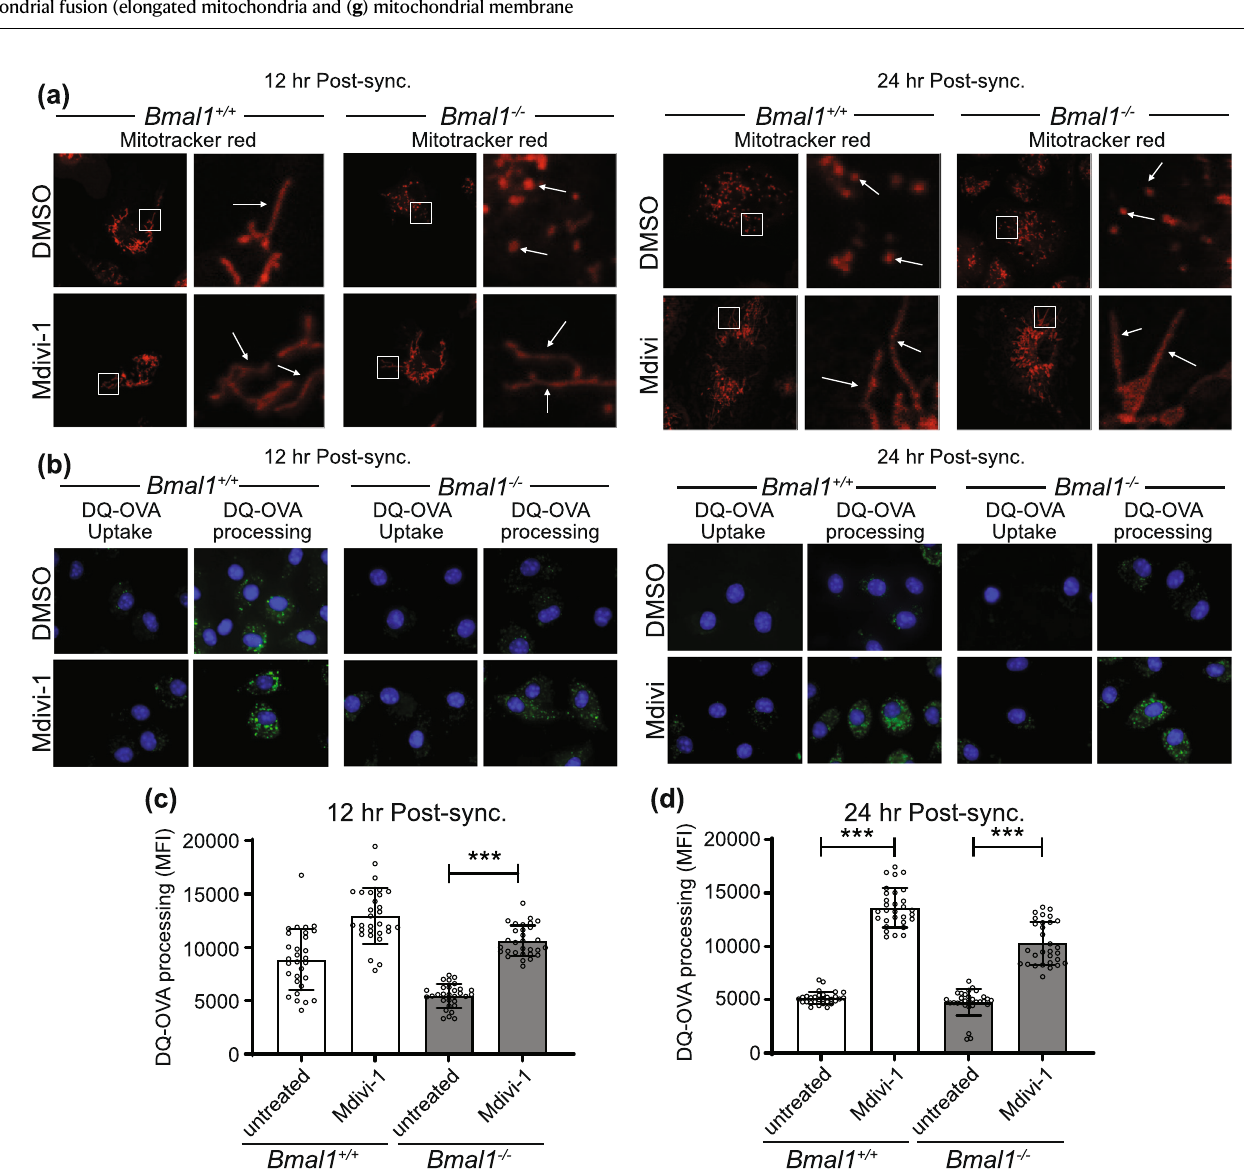
potential were quanti fi ed by confocal microscopy ( n =3 biologically independent samples). h Bmal1 +/+ and Bmal1 − / − BMDCs were stained with Mitotracker green FM dye at indicated time points post synchronisation and analysed by fl ow cytometry ( n =3 biologically independent samples). Data shown is mean with error bars representing±SEM. Mitochondrial fi ssion and membrane potential in Bmal1 +/+ were predicted to be circadian by cosinor analysis ( e and g ). Data were compared byone-wayANOVAwithTukey ’ spost-hoctestformultiplecomparisons( h ).Source data are provided as a Source Data fi le.